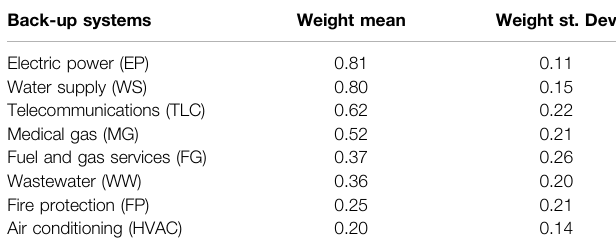
TABLE 3 | Summary of results for the performed